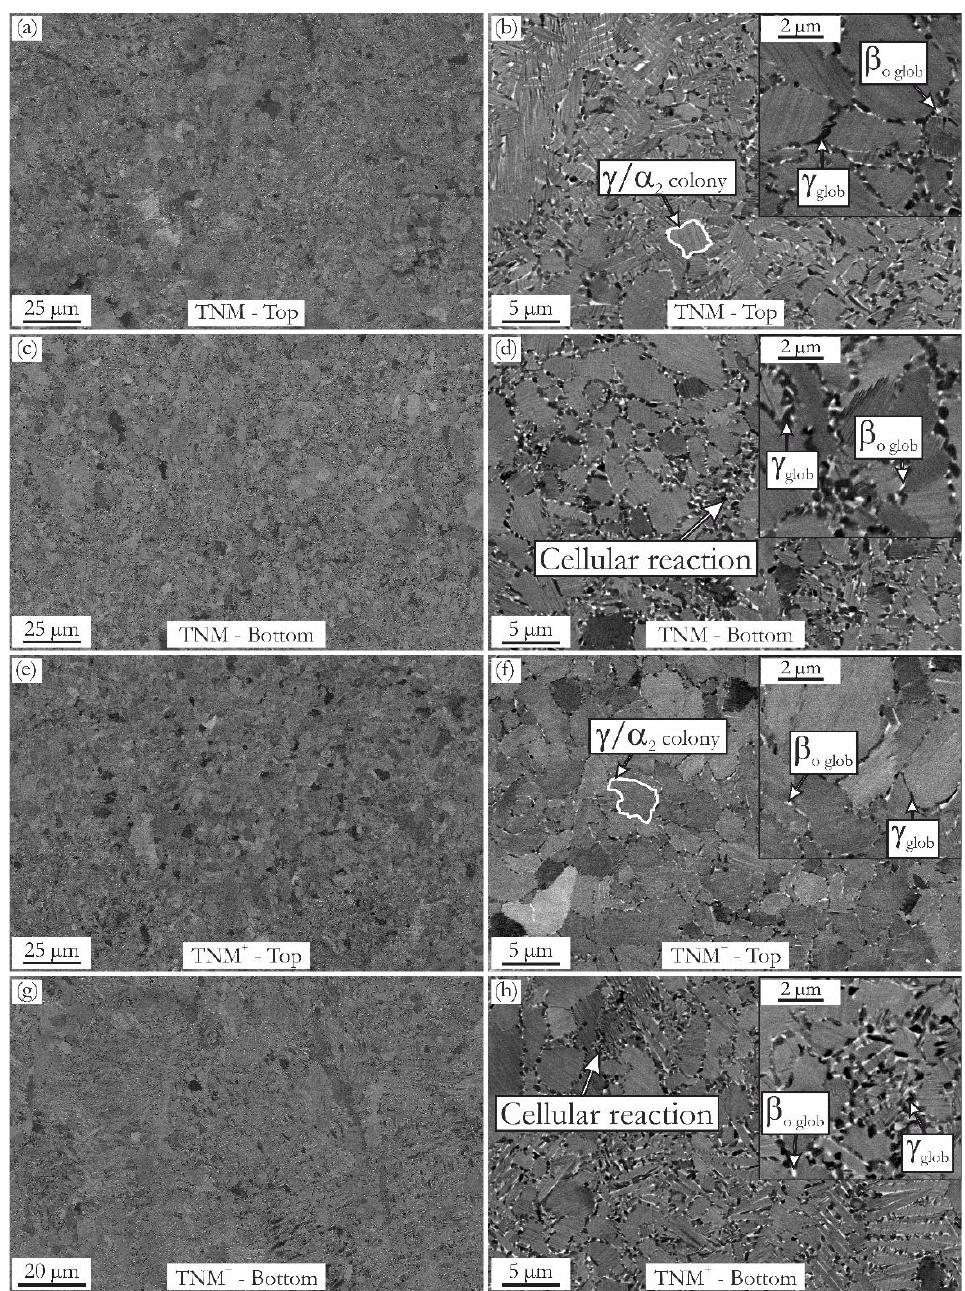
Figure 3. SEM-BSE images of the as-built TNM and TNM + specimens reveal the appearance of similar microstructures. Whereas the top regions ( a , b , e , f ) exhibit lamellar microstructures with small fractions of γ glob and β o glob , the microstructures towards the bottom of the specimen ( c , d , g , h ) undergo a microstructural aging via a cellular reaction, thus transforming part of the lamellar colonies into γ glob and β o glob . The microstructural constituents are marked in the micrographs, where β o appears very bright, γ shows a dark contrast and the α 2 /γ -lamellar colonies appear in an intermediate grey.